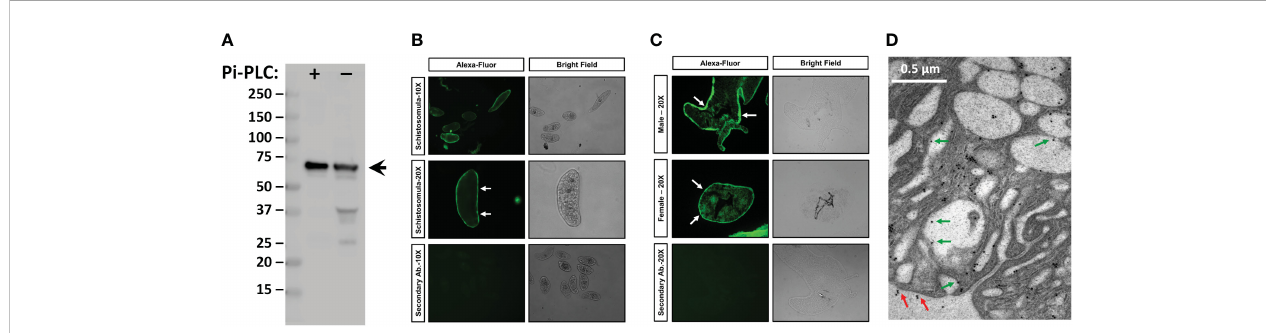
FIGURE 6 Immunolocalization of SmTAChE. (A, left) Anti-SmTAChE antibodies bind to a protein of the expected size of SmTAChE (~75 kDa, arrow) as seen by western blot analysis in a protein preparation obtained following Pi-PLC treatment of live adult males ( + ) and in a total male lysate (not treated with Pi- PLC, - ). Numbers to the left indicate molecular mass markers (kDa). (B) Immunostaining of SmTAChE in 7-day old cultured schistosomula. (C) Immunostaining of SmTAChE in sections of adult male longitudinal section; ( C , top panel) and adult female (cross section; C , middle panel) parasites. Magni fi cation level (10X or 20X) is indicated to the left. An Alexa-Fluor 488 conjugated secondary antibody was used for detection and was used as a control. Both fl uor (left panels) and bright (right panels) fi elds are shown for each section. Strong tegumental staining is seen in schistosomula and adults (white arrows). (D) Electron micrograph of the adult tegument showing immunogold labeling of SmTAChE. Red arrows indicate localization of gold particles on the external surface of the worm and green arrows indicate the presence of some gold particles lining tegumental pits.